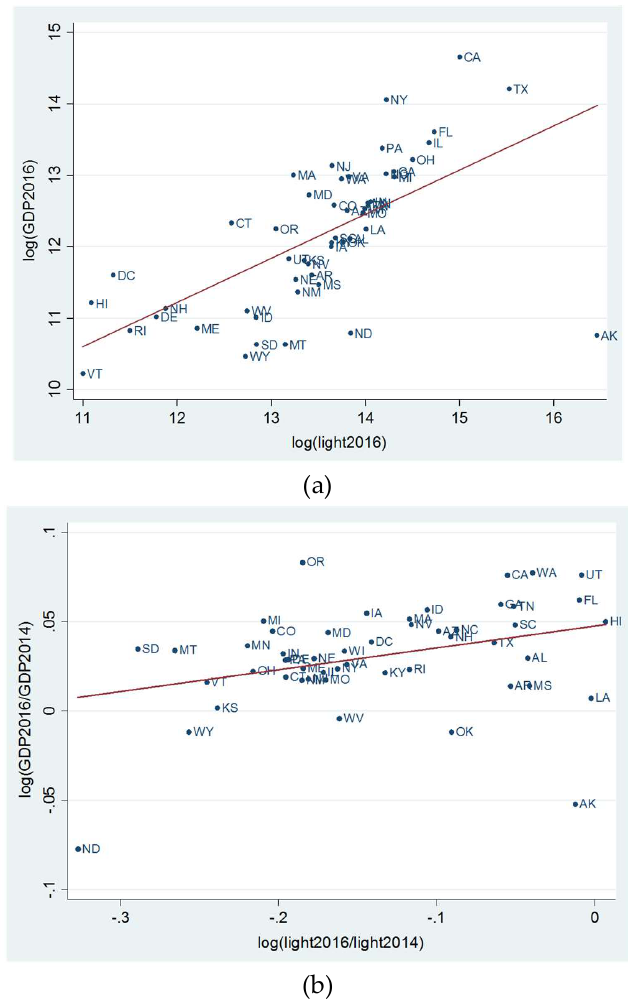
Figure 2. State lights (average monthly composites) and GDP annual (2016) ( a ) and 2-year growth (2014-2016) ( b ) data.